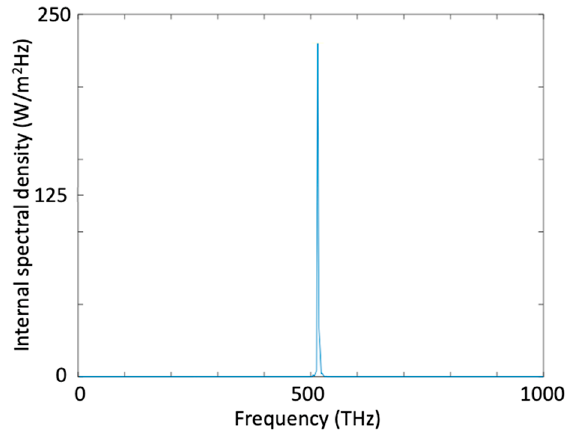
Figure 10. Intensity spectral density at the band-pass filter output for generation of a wave at 515 THz.